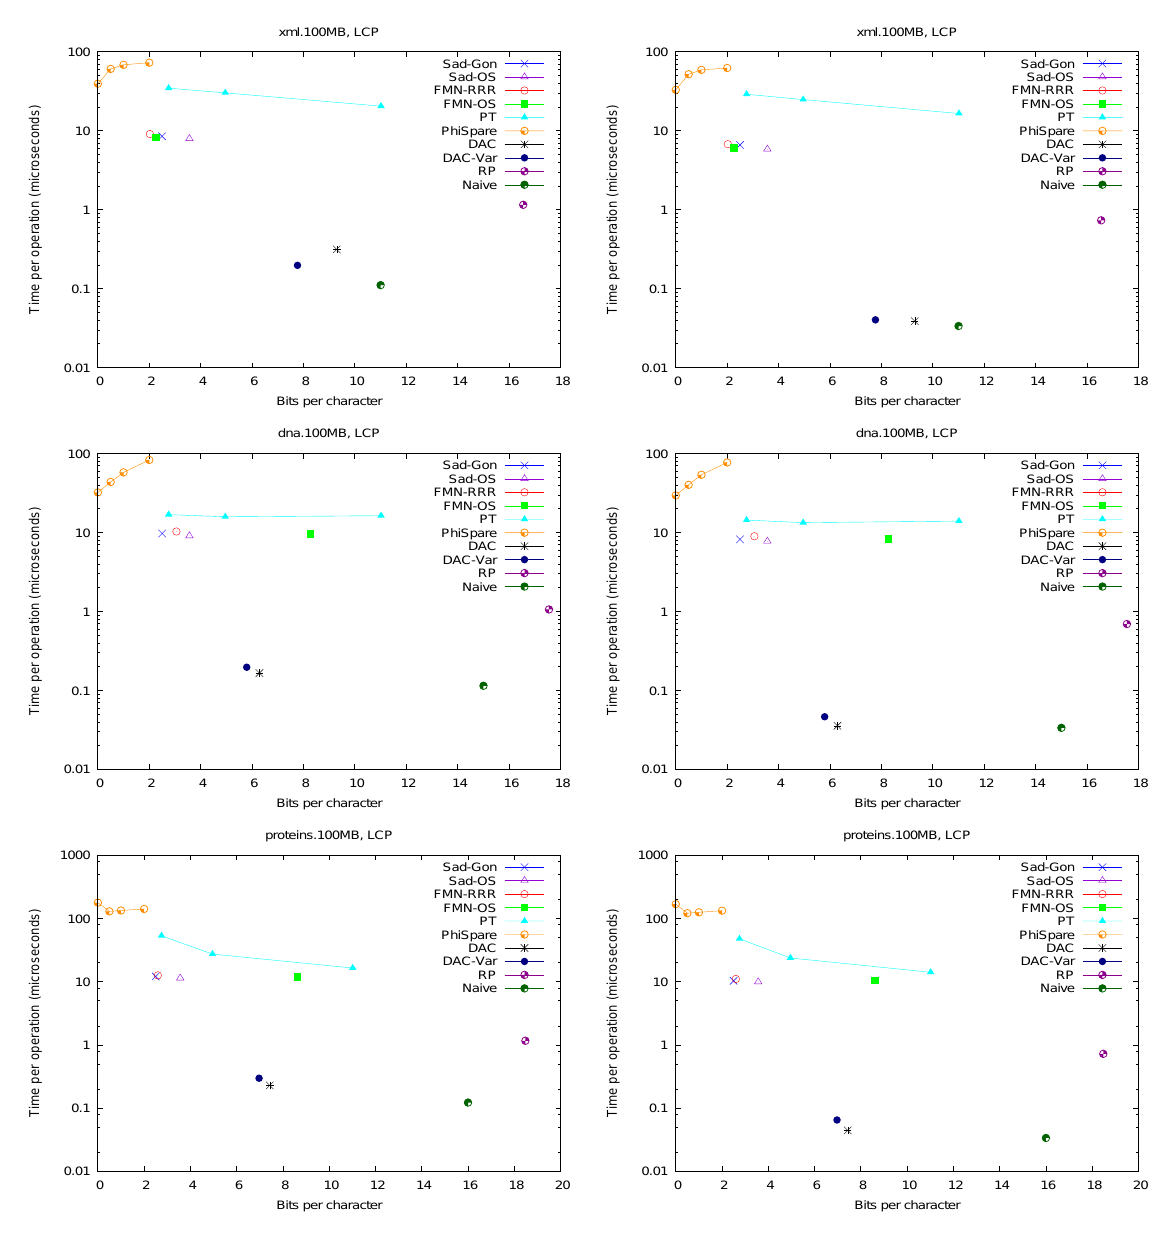
Figure 2. Space/Time for accessing array LCP . On the left for random accesses and on the right for sequential